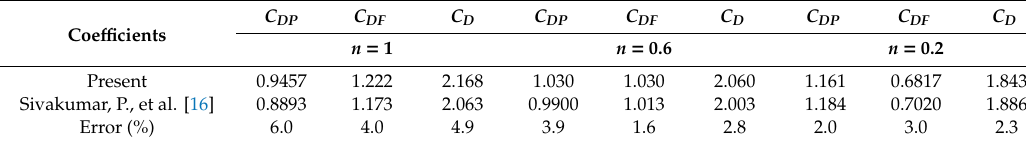
Table 4. Numerical values of drag coe ffi cients with power-law analysis around an elliptic obstacle. Coe ffi cients